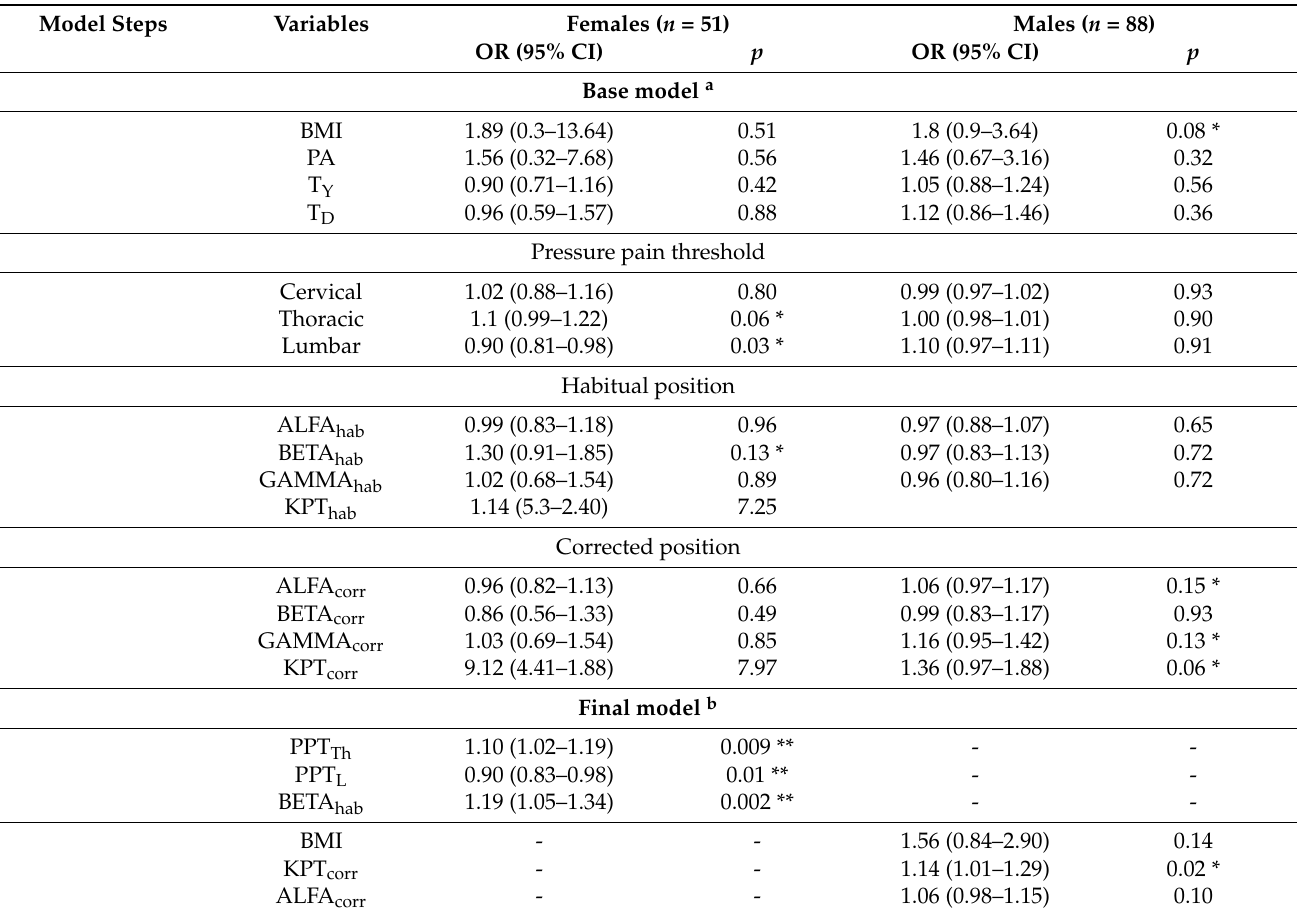
Table 2. The logistic regression model estimation in females and males considering low back pain (NRS < 3) as dependent